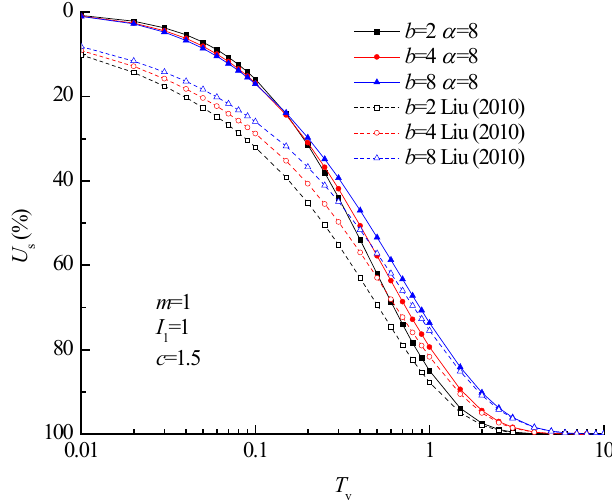
Figure 11. Influence of the b value on ACDS ( m = 1, c = 1.5) [23].